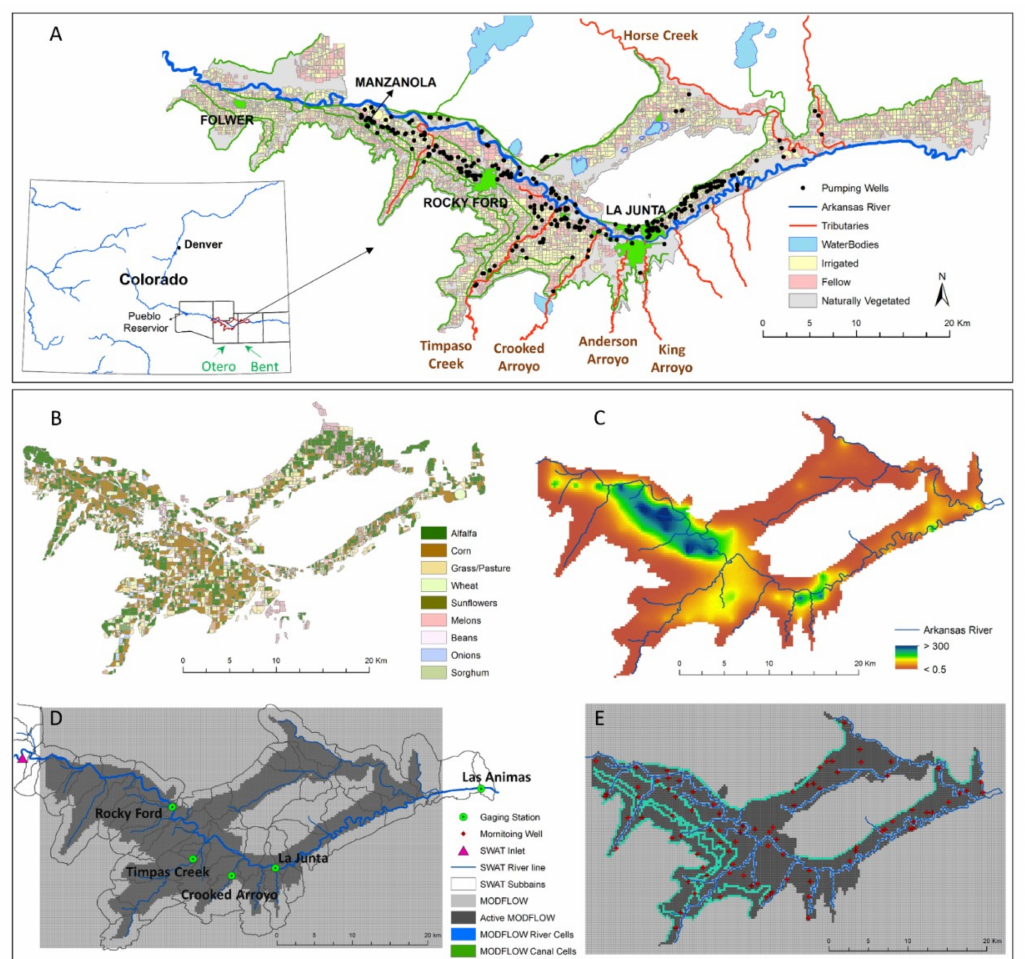
Figure 2. ( A ) Location of the study region in Colorado; ( B ) crop type for each cultivated field for the year 1999; ( C ) horizontal hydraulic conductivity (m / day) for layer 1; ( D ) sub-basins created by the SWAT; the inlet and outlet gauging stations are also shown; ( E ) MODFLOW grid cells; the 89 monitoring well locations and MODFLOW river cells are also shown.